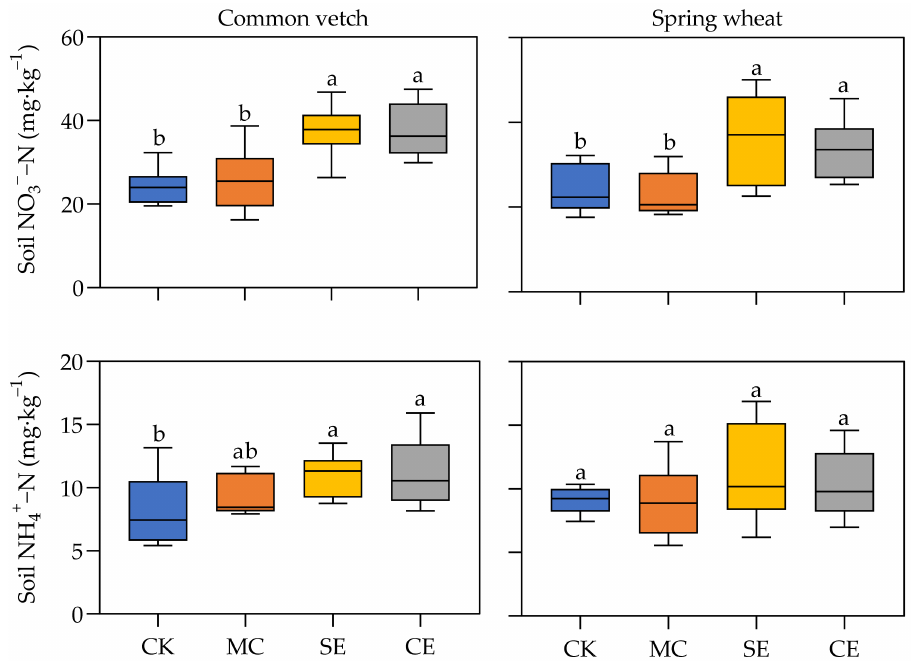
Figure 2. Soil nitrate nitrogen (NO 3 − -N) and soil ammonium nitrogen (NH 4 + -N) content of the two forage crops. The significant differences were labeled with letters using Duncan’s notation, from largest to smallest: a, b. If there is no significant difference between two values, the same or overlapping letters are used for both